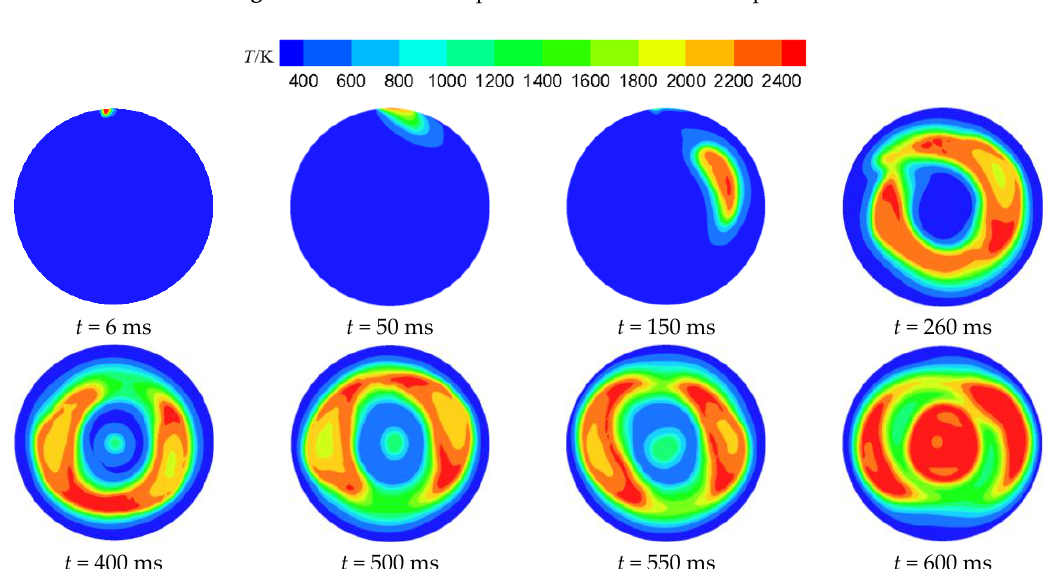
Figure 8. Numerical temperature field of combustor cross section (X = 130 mm).